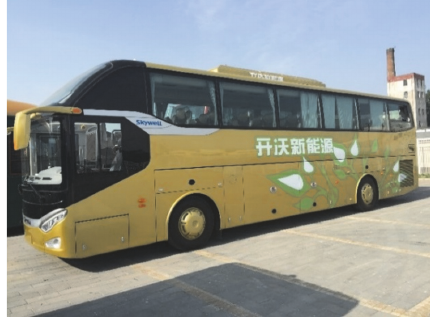
Figure 20: The vehicle carrying the new hybrid electric system.